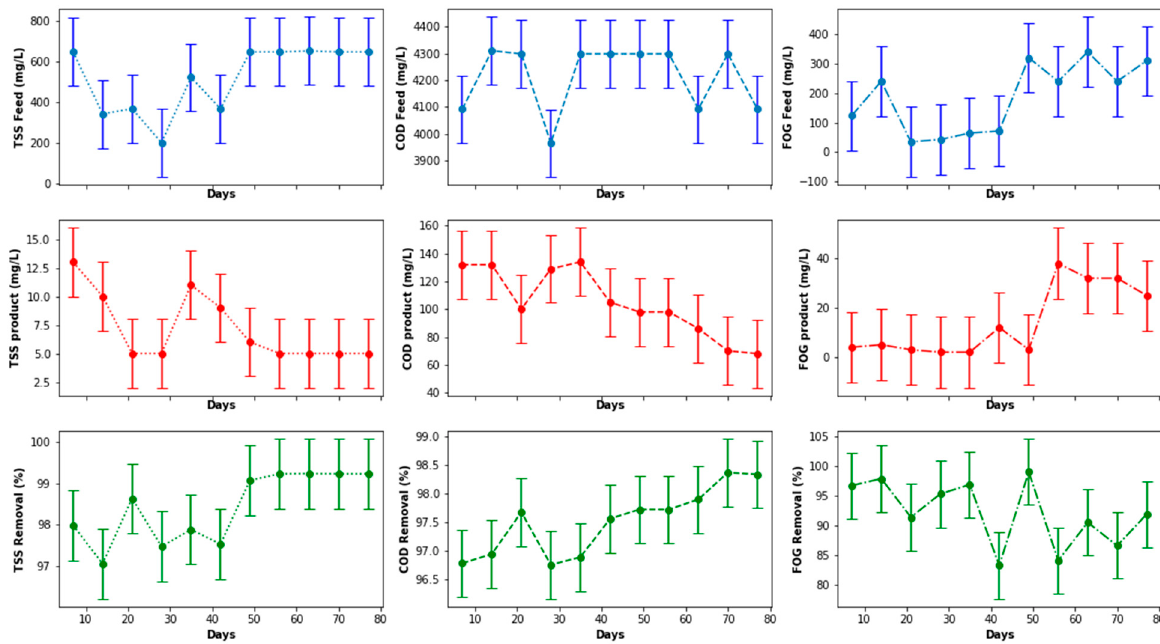
Membranes 2021 , 11 , x FOR PEER REVIEW Figure 19. Overall performance of the pretreatment–EGSB–MBR system with respect to COD, TSS, and FOG removal.